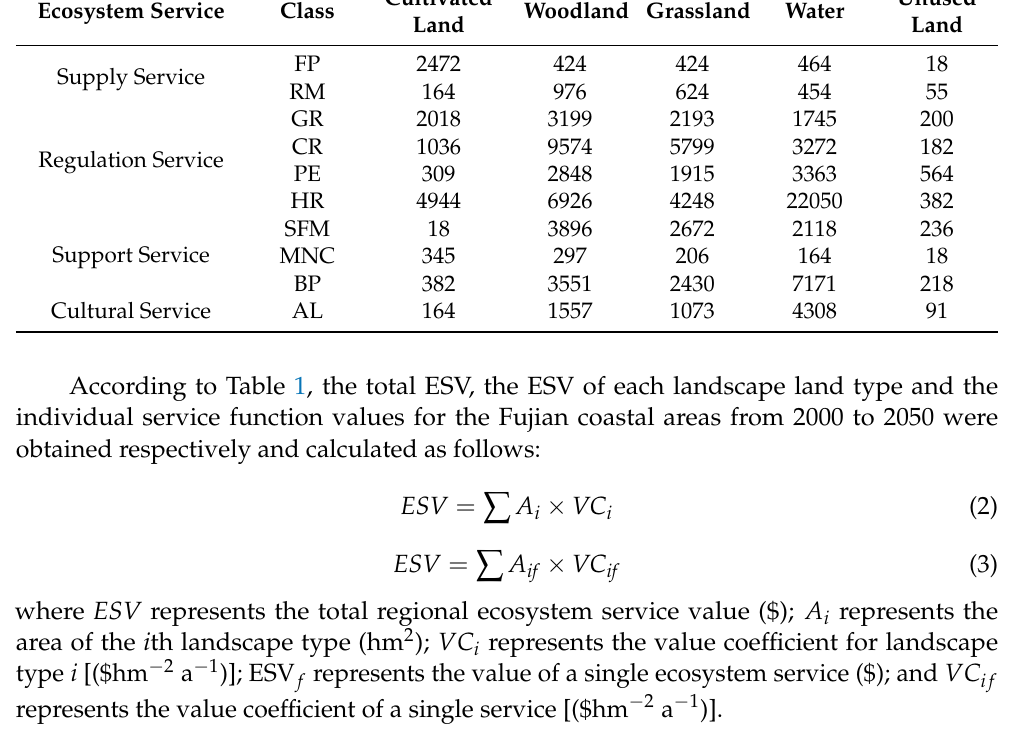
Table 1. Coefficient tables of ESV in the study area (Unit: Chinese yuan (RMB)/ha). Cultivated Ecosystem Service Class